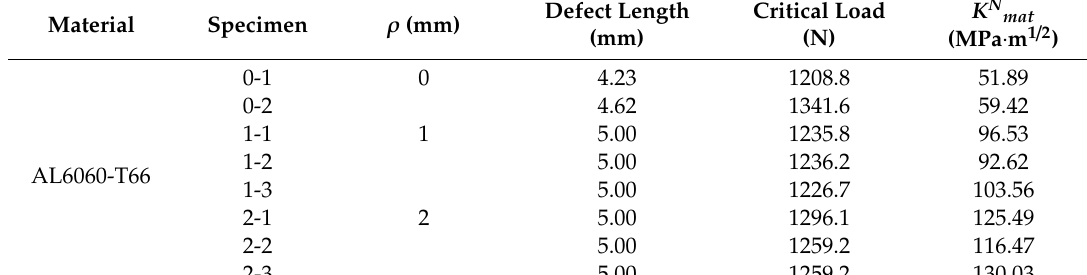
Figure 8. Load–displacement curves of some of the fracture tests.